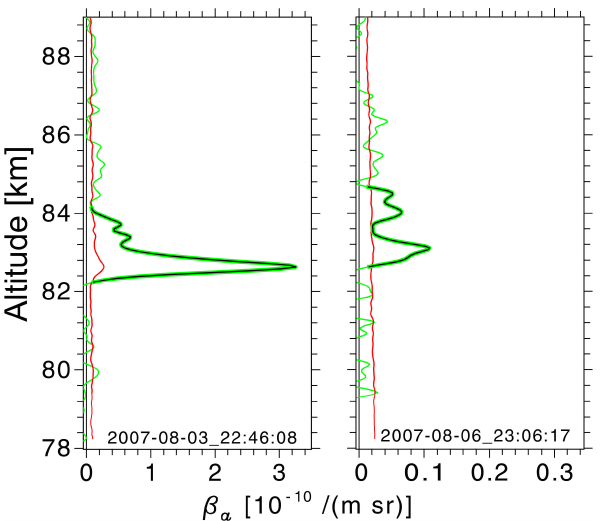
Fig. 4. Aerosol backscatter coefficients (green) measured by the ALOMAR RMR-Lidar during MASS1 (left panel) and MASS2 (right) panel from the lidar system looking close to the rocket tra- jectory. During MASS1 the integration time was reduced to 1min, while during MASS2 14min integration time was used to detect the weak NLC (note the different scaling on the abscissa). The red lines indicate the 1-sigma measurement uncertainty.